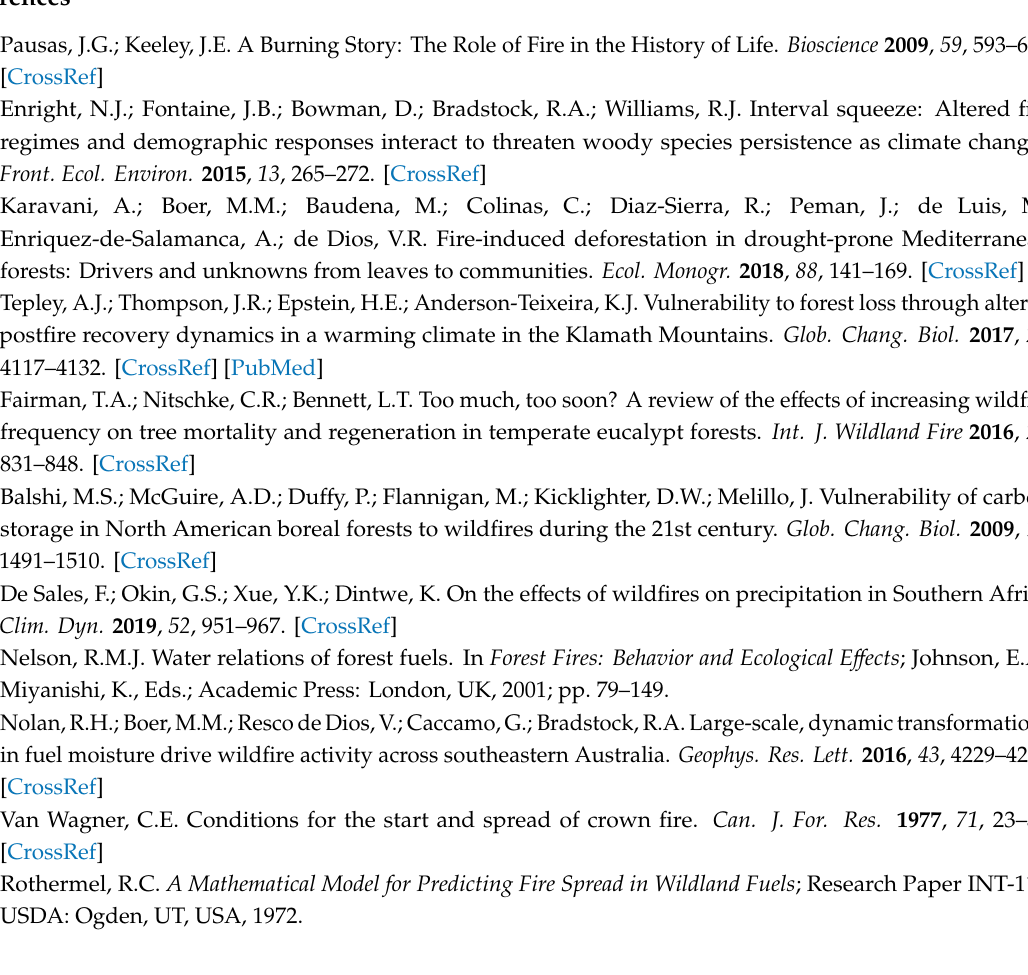
Figure S1: Scanned images of the leaves of each species used in the common garden study. Not to scale.; Figure S2: Turgor loss point ( Ψ TLP ± 1SE) of eight Eucalyptus species, calculated from standard pressure-volume curves (bench dehydration method) and Ψ TLP calculated from progressive observations of leaf water potential ( Ψ leaf ) and live fuel moisture content (LFMC) of plants subject to imposed drought. Mean absolute error is 0.19